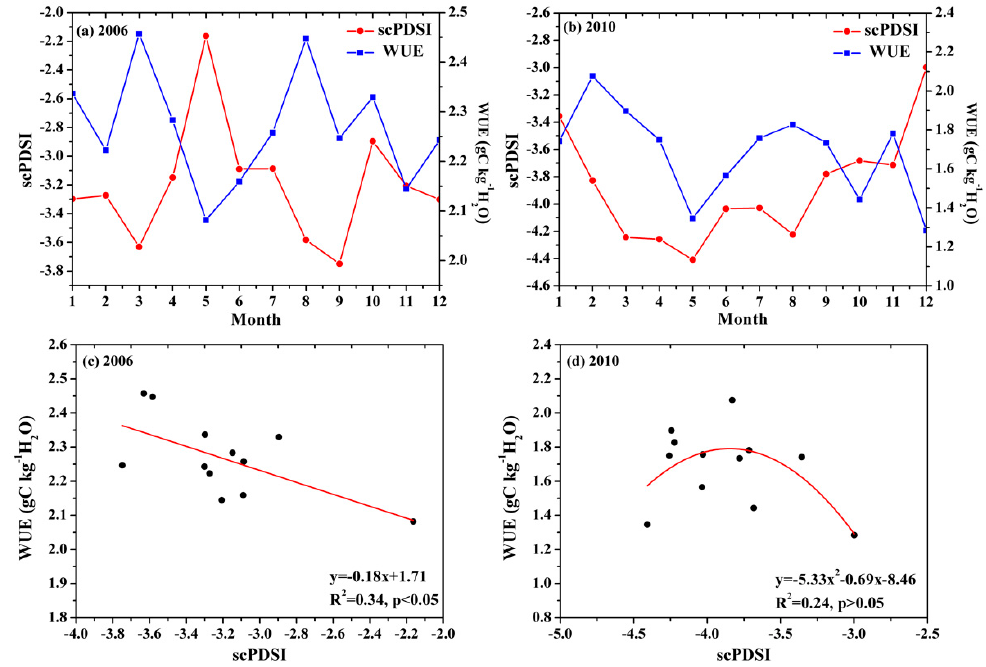
Figure 9. Responses of monthly WUE to drought: ( a ) seasonal variations of WUE and scPDSI in the selected drought region (Figure 8a) in 2006; ( b ) seasonal variations of WUE and scPDSI in the selected drought region (Figure 8b) in 2010; ( c ) the relationship between monthly WUE and monthly scPDSI in 2006; ( d ) the relationship between monthly WUE and monthly scPDSI in